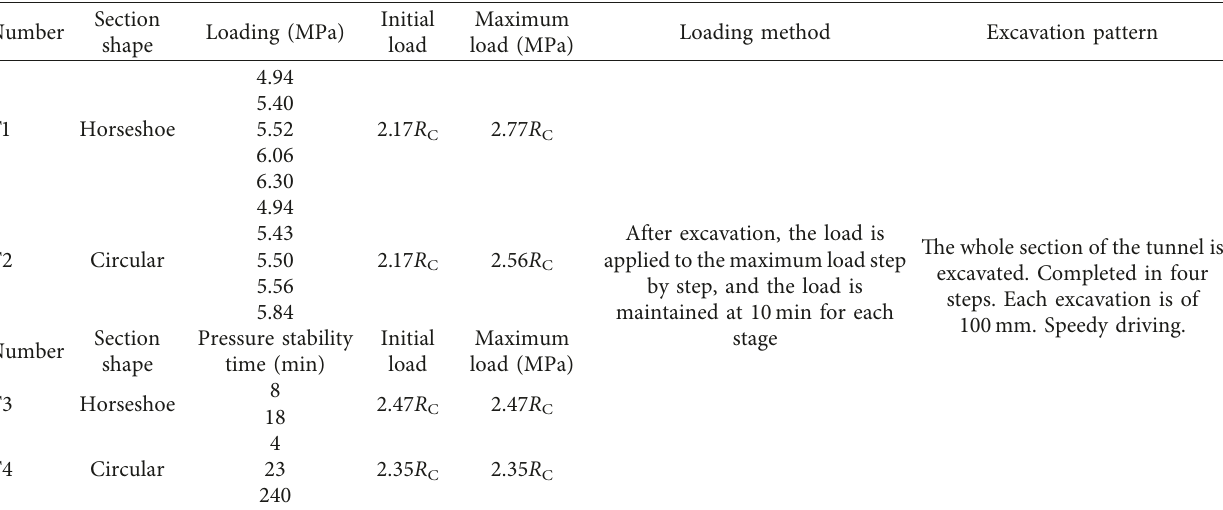
Figure 6: A working result from the electrical resistance grid technique. Table 3: The loading plan for physical